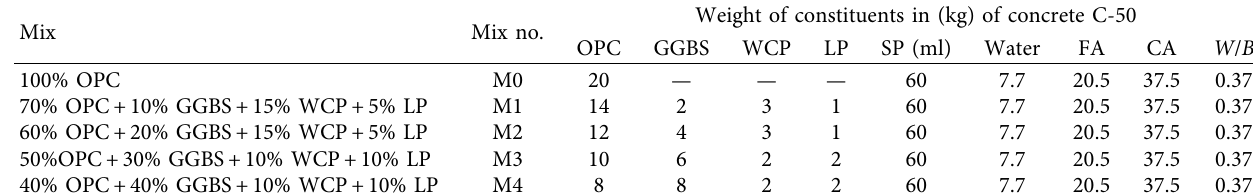
Table 2: Concrete mix combinations for C-50 used in the present investigation.